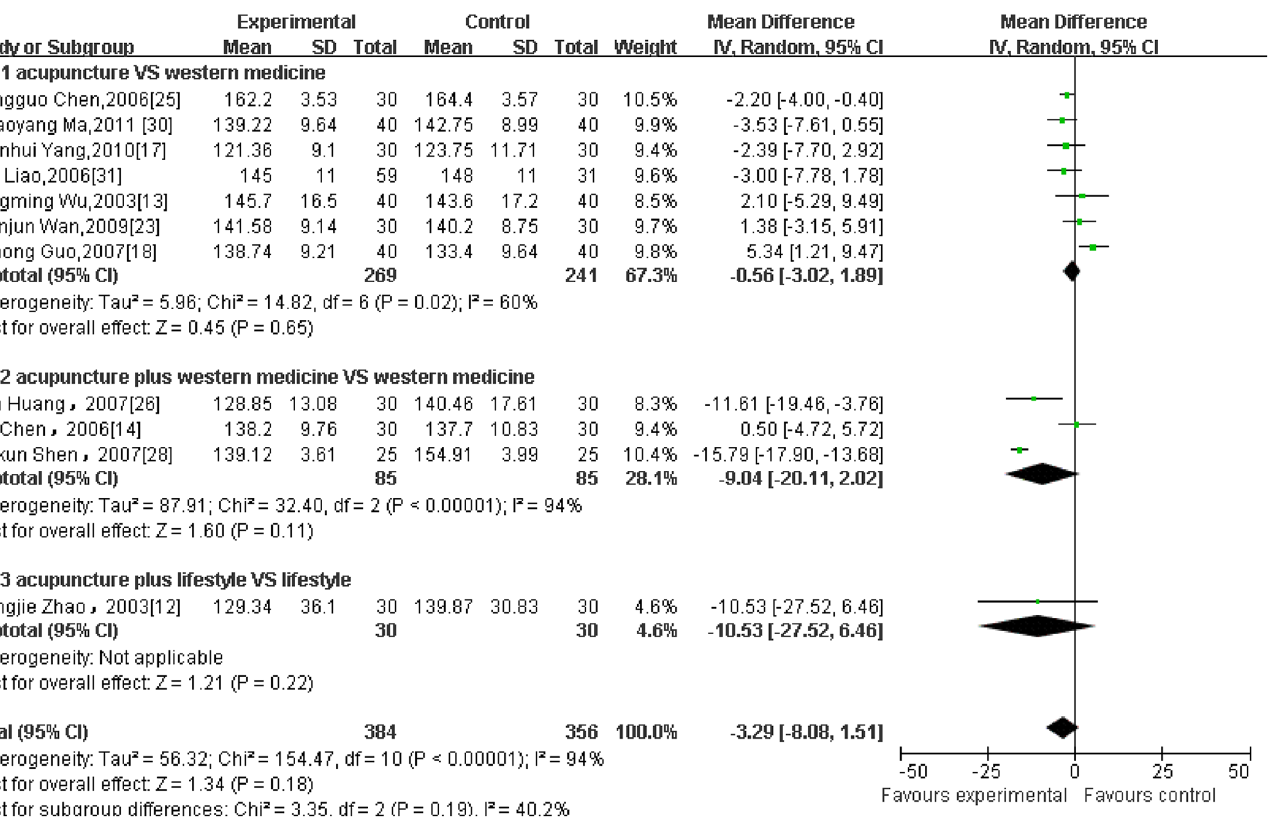
Fig 2. The forest plot of outcome measure ‘ SBP after intervention.